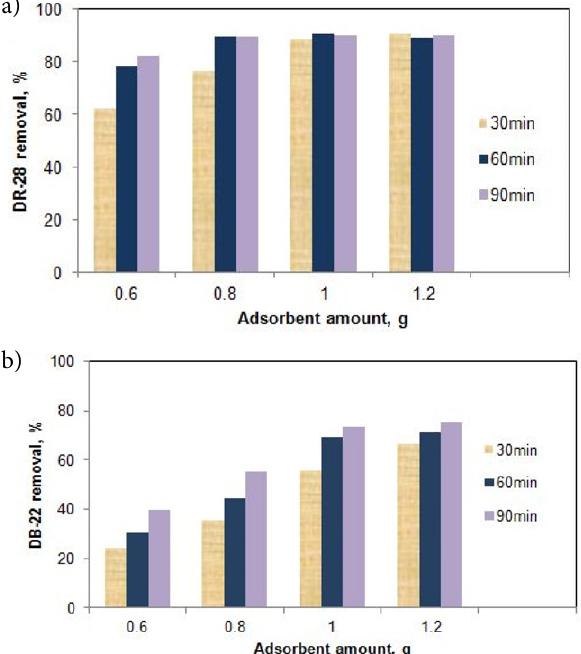
Fig. 6. Effect of KZF amount on the removal of (a) DR-28 and (b) DB-22 (initial concentration: 30 mg/L, temperature: 21 °C, initial pH: